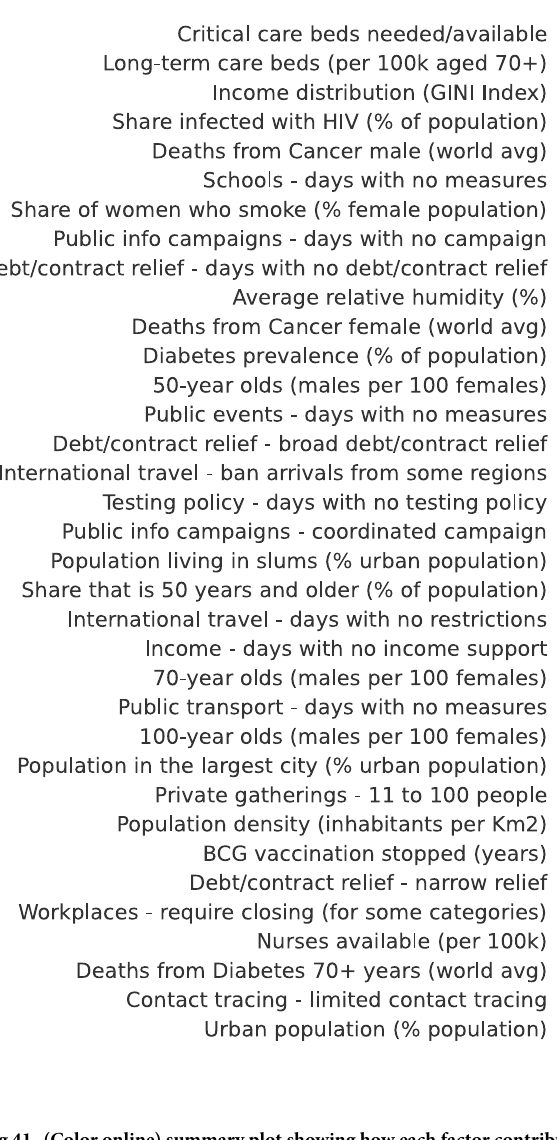
PLOS ONE | https://doi.org/10.1371/journal.pone.0264893 April 8,